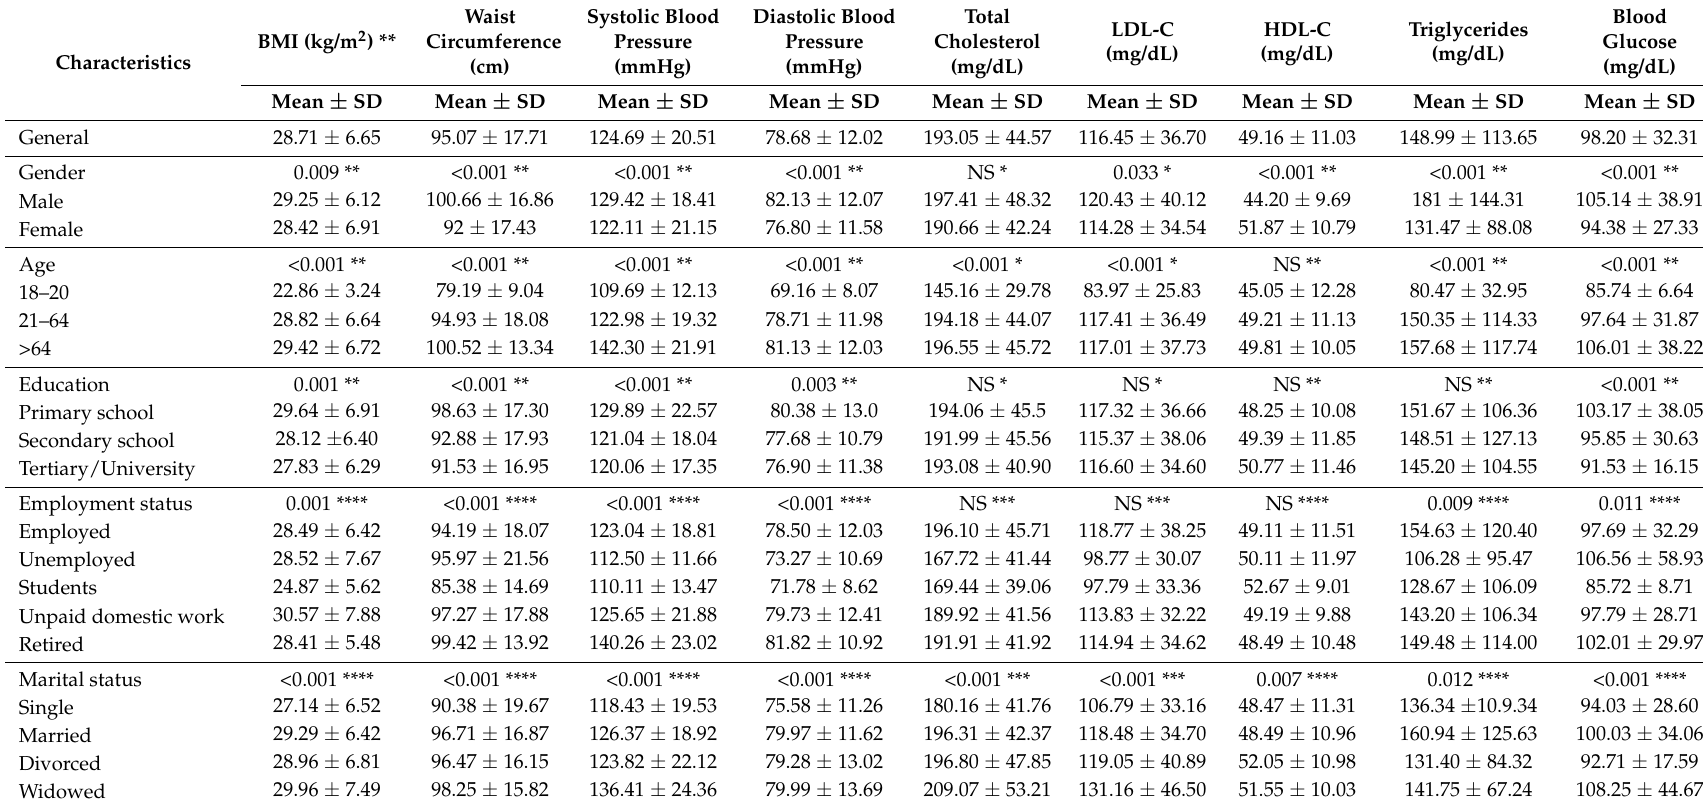
Table 2. Anthropometrics, blood pressures and blood test analysis of